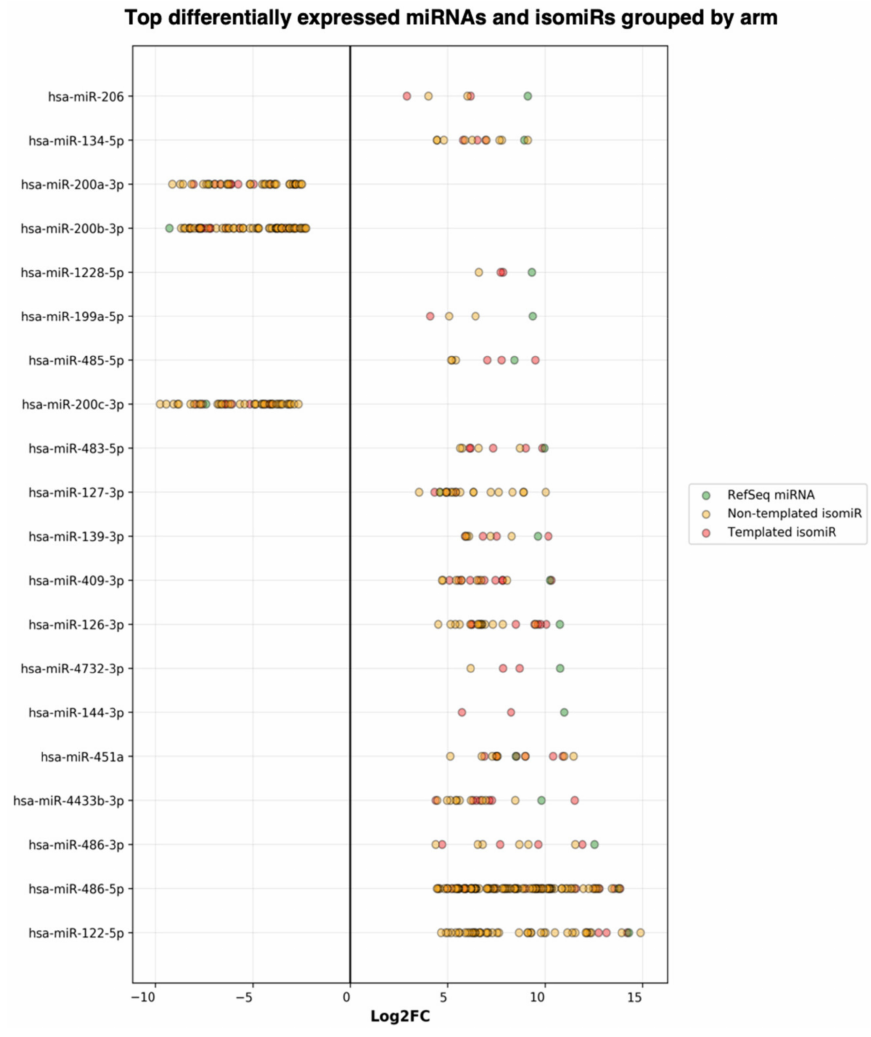
Figure 9. Summary of the top DE miRs and isomiRs grouped by miR arm. The number of miR arms presented in the report can be specified by the user. Table 2. Outputs of DE analyses of miR-200b-3p and isomiRs performed by miRGalaxy in comparison with the study of Rubio and co-workers [34] (only statistically significant results are